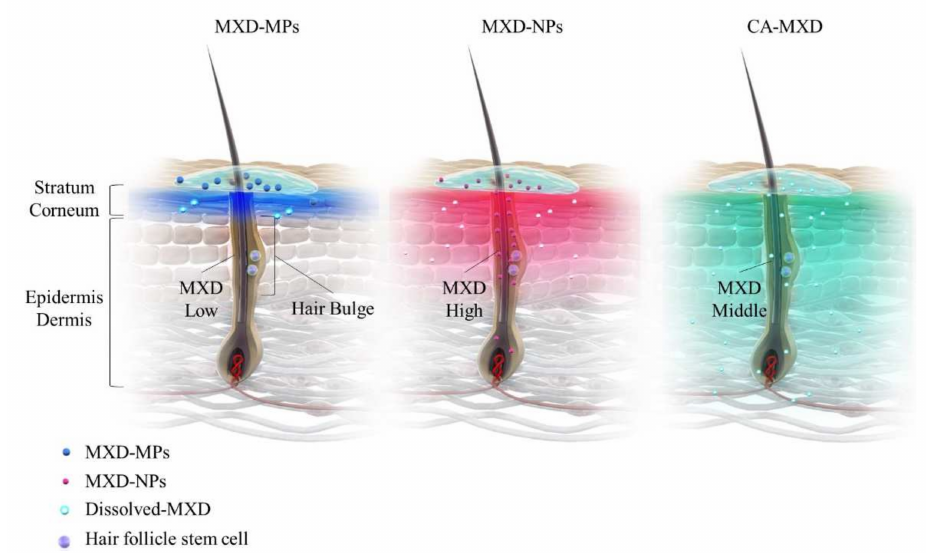
Figure 8. Schemes for drug delivery into the hair bulge and bulb region for MXD-MPs (powder type), MXD-MPs (NPs type) and CA-MXD (solution type)